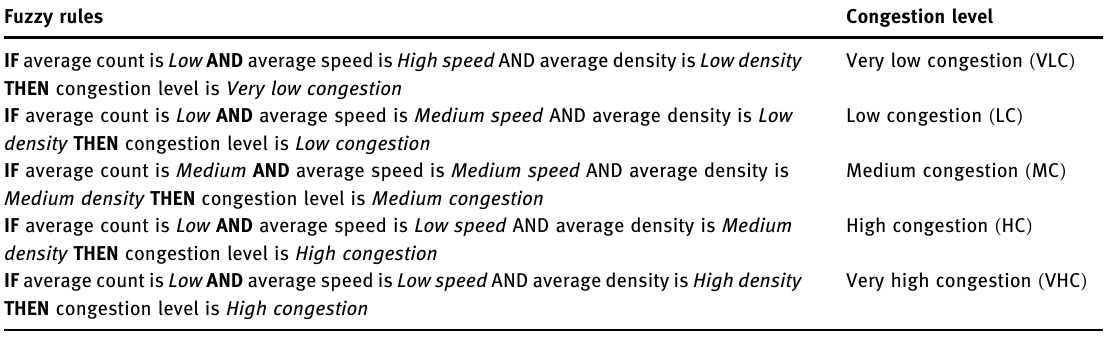
Table 5: Decision rule examples of fuzzy logic